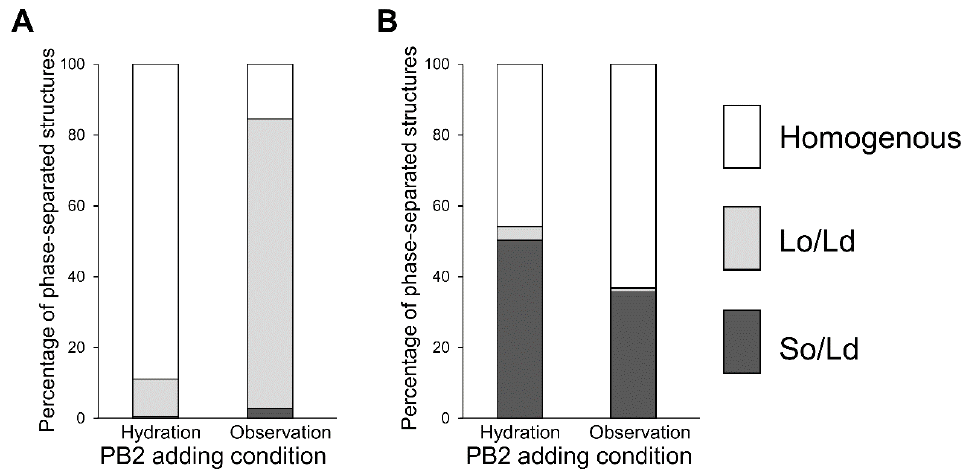
Figure 4. Percentage of phase-separated structures. 1,2-Dioleoyl-sn-glycero-3-phosphocholine (DOPC)/1,2-dipalmitoyl-sn-glycero-3-phosphocholine (DPPC)/cholesterol (Chol) with various additions of procyanidin b2 (PB2) are shown. Lipid compositions of the observed liposomes in the experiment were DOPC/DPPC/Chol ( A ) 40:40:20 and ( B ) 50:50:0.